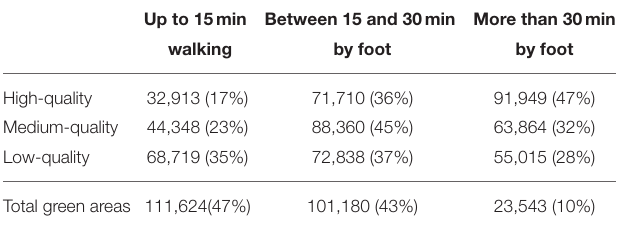
TABLE 6 | Population with access to urban green spaces in Talca, with quality levels obtained from the survey. Up to 15min Between 15 and 30min More than 30min walking walking